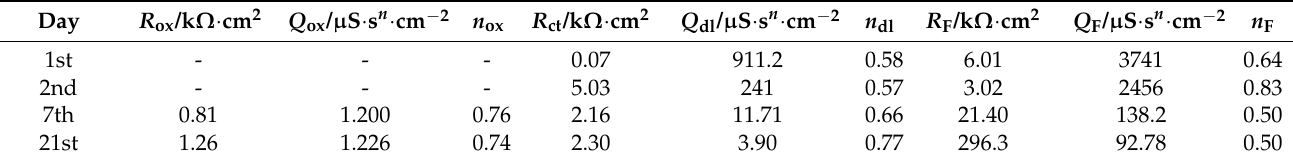
Table 3. EIS data for CuSn6 for continuous immersion in simulated acid rain at pH